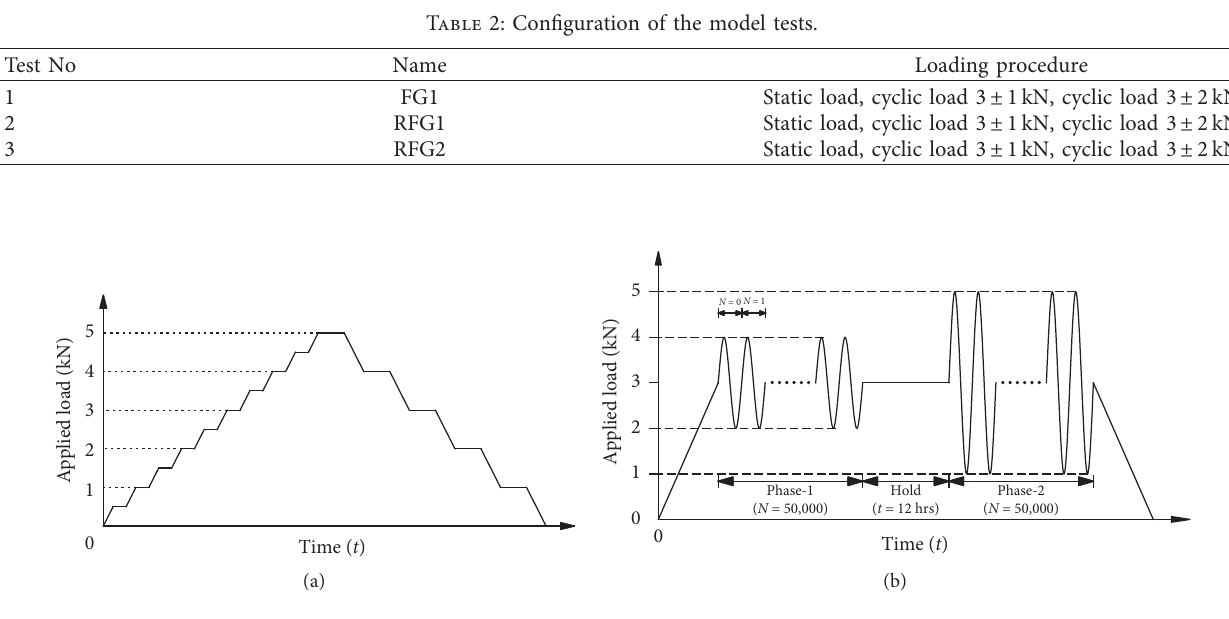
Figure 5: Applied load in the model test: (a) static load and (b) cyclic load.